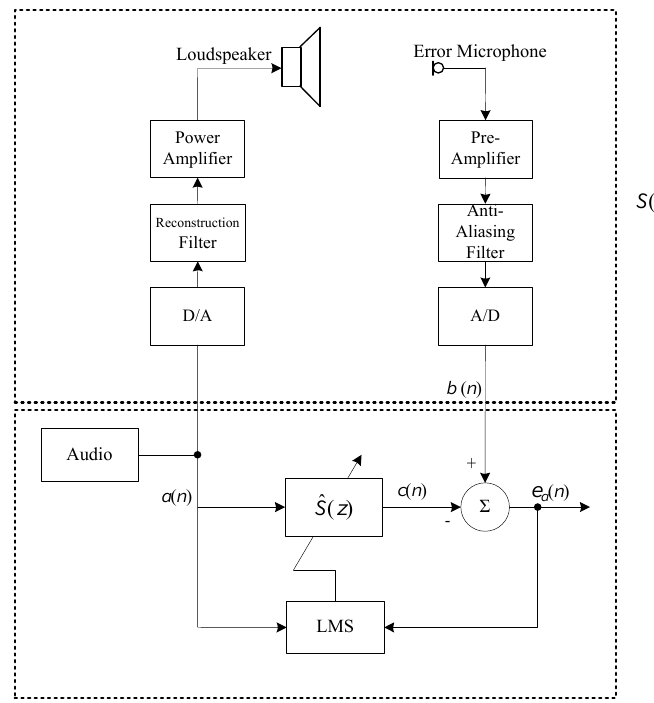
Figure 3. Block diagram of using natural sound for secondary path modeling.